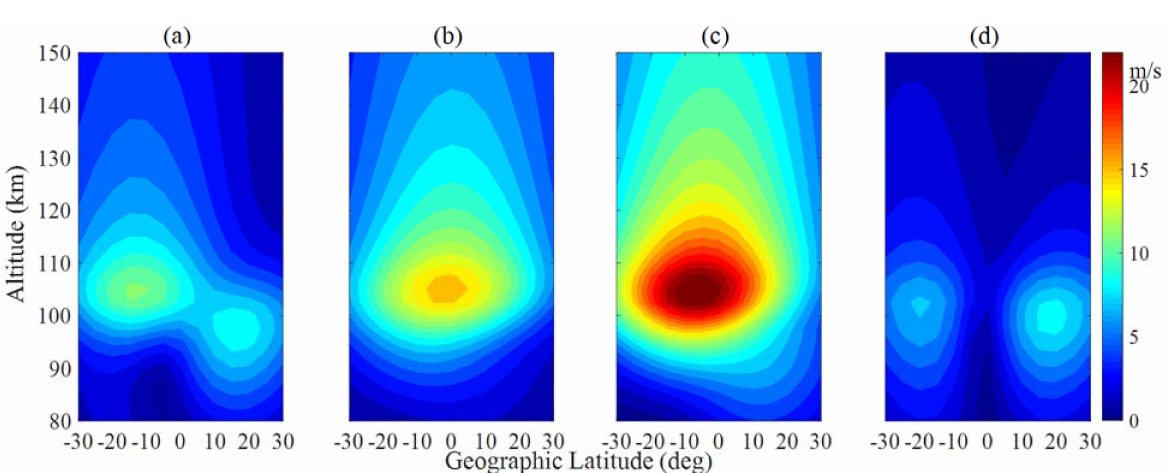
Figure 9. The distributions of the amplitudes for the DE3 tide in the zonal wind during ( a ) March, ( b ) June, ( c ) September, and ( d )